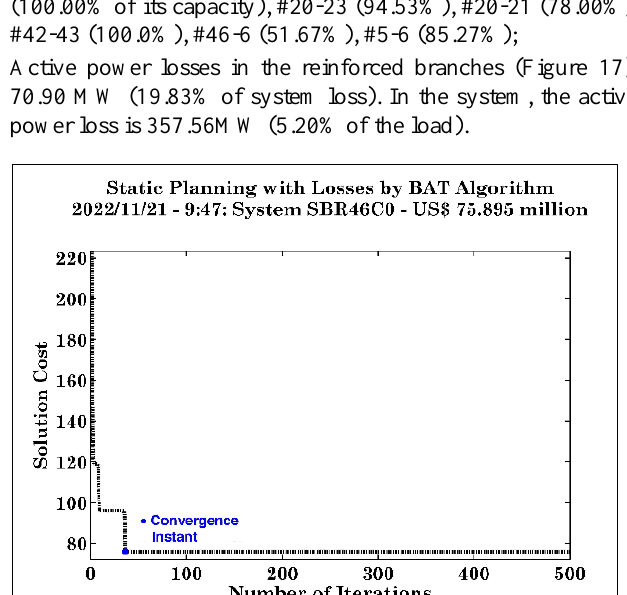
Figure 14: Case WR - SB-46/79 test system.